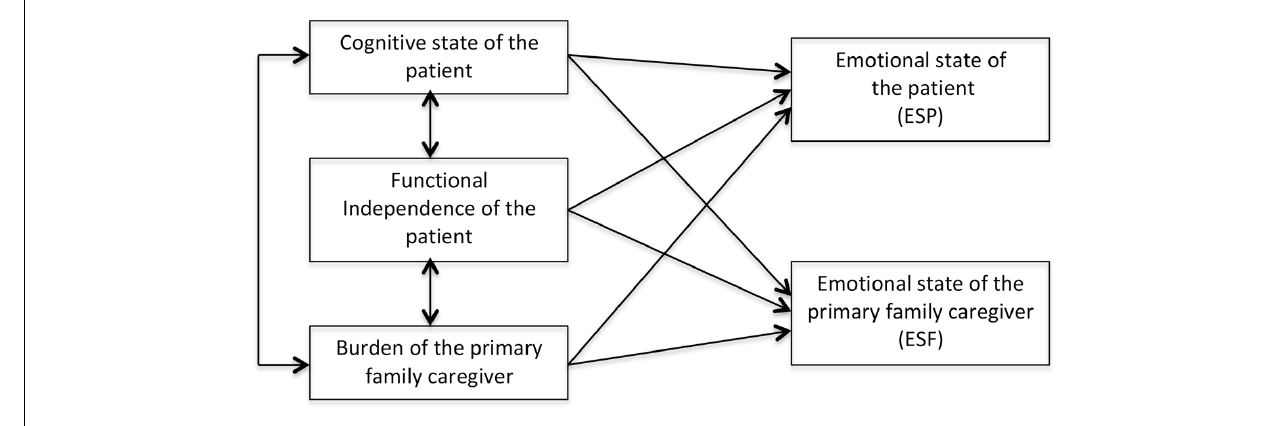
FIGURE 1 | Theoretical structural model.